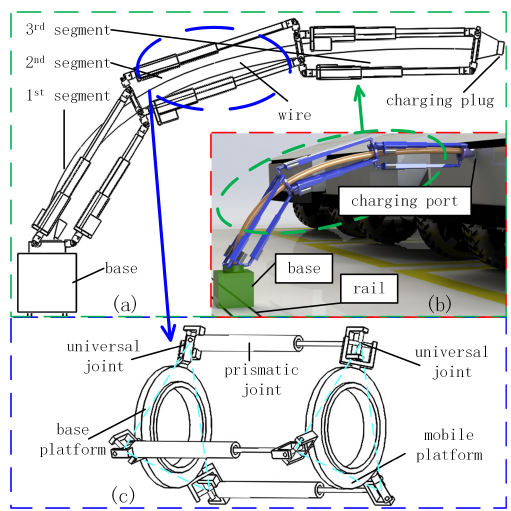
Figure 1. Concept design of the EV charging robot. ( a ) Structure of the whole robot; ( b ) assumed charging scenario; ( c ) schematics of the 3 universal-prismatic-universal (3UPU) mechanism.